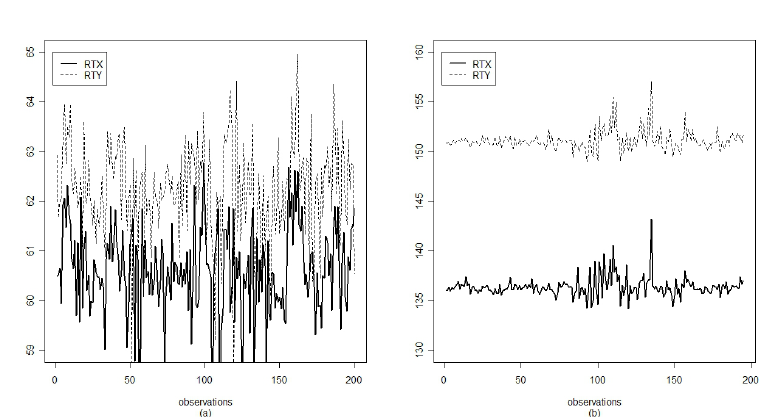
Figure 3. (a) Mean residual intensity of pretonic syllables perceived as bearing secondary stress (dotted line – RTY process) and mean residual intensity of other pretonic syllables (full line – RTX process). (b) Mean residual F 0 of pretonic syllables perceived as bearing secondary stress (in red – RTY process) and mean residual F 0 of other pretonic syllables (in blue – RTX